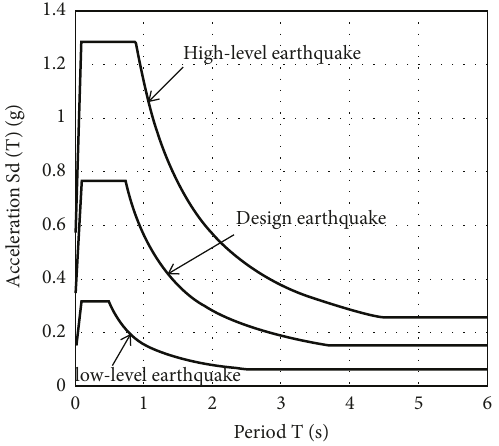
Figure 1: Design response